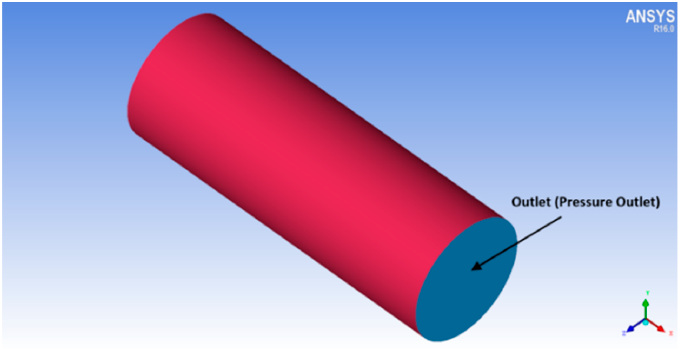
Actuators 2020 , 9 , x FOR PEER REVIEW